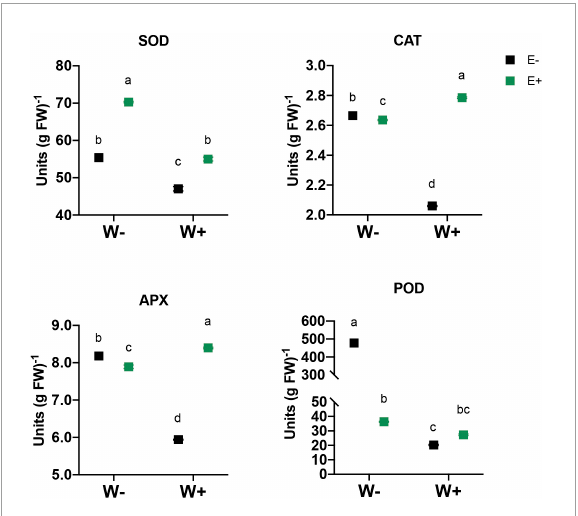
FIGURE4 Effect of fungal Antarctic endophytes and water deficit treatments on the activities of the antioxidant enzymes (CAT, POD, SOD, and APX) in the leaves of strawberry plants. Different letters indicate significant differences ( P < 0.05; two-way ANOVA). Bars represent means ± SE from three independent